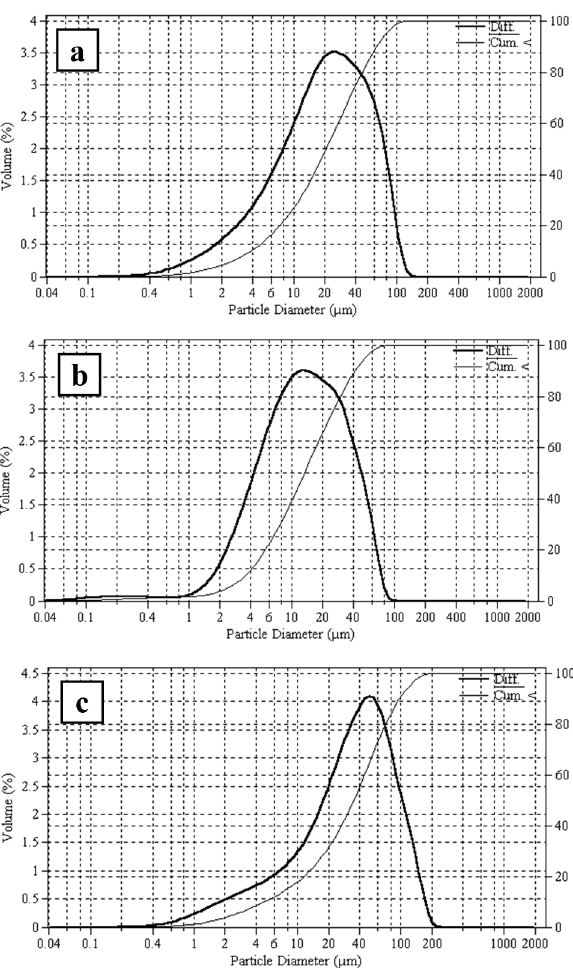
Figure 2: Example differential (left scale) and cumulative (right scale) volumetric (mass) size distributions of struvite crystals: a) pH 9, τ 900 s, b) pH 11, τ 900 s, c) pH 9, τ 3600 s – [SO 42– ] [PO 43– ] 1.0 mass% (corresponding to 1, 4 and 6 in Table 2). RM